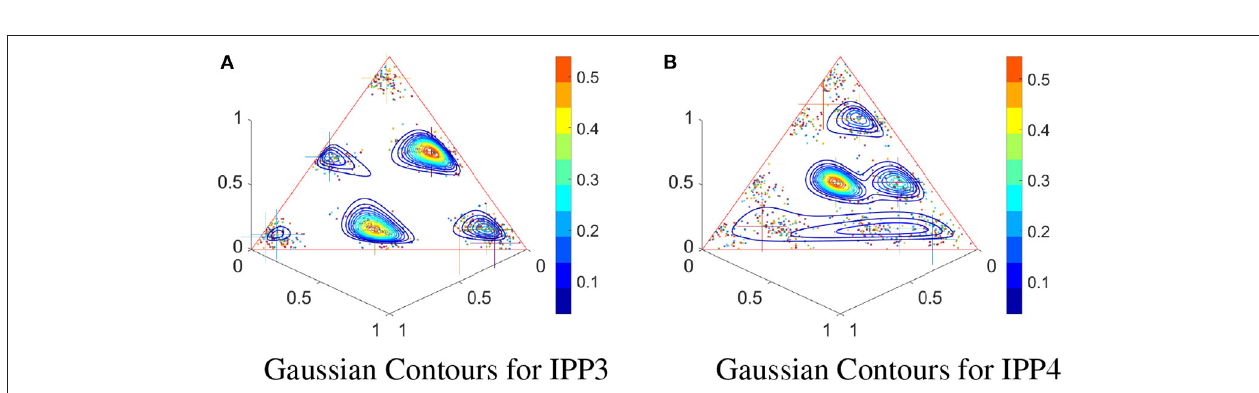
FIGURE 10 | Gaussian mixture models on IPPs: (A) 1,000 2-event realizations from the original 1,000 realizations of IPP3, and the density contours by using the Gaussian mixture model. (B) The same as (A) except for IPP4.